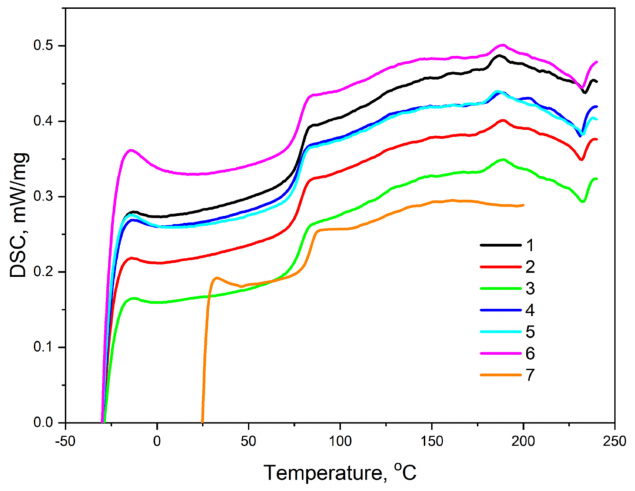
Figure 9. Differential scanning calorimetry (DSC) thermogram of PVC: 1—0 rpm; 2—500 rpm; 3—1000 rpm; 4—1500 rpm; 5—2000 rpm; 6—2500 rpm; 7—PVC